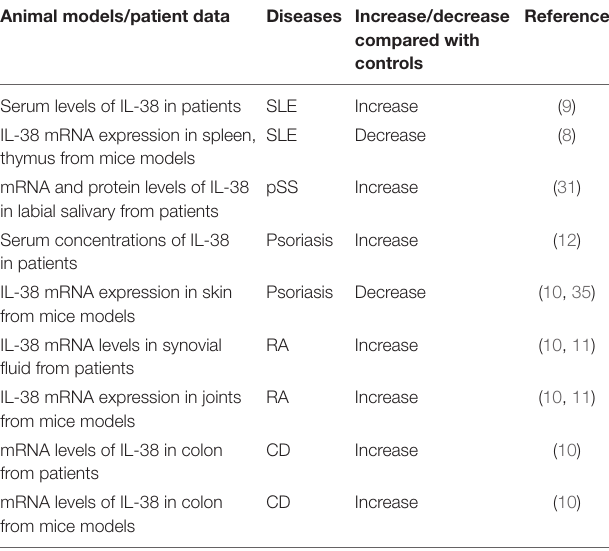
TABLe 1 | Aberrant expression of IL-38 in rheumatic autoimmune diseases.